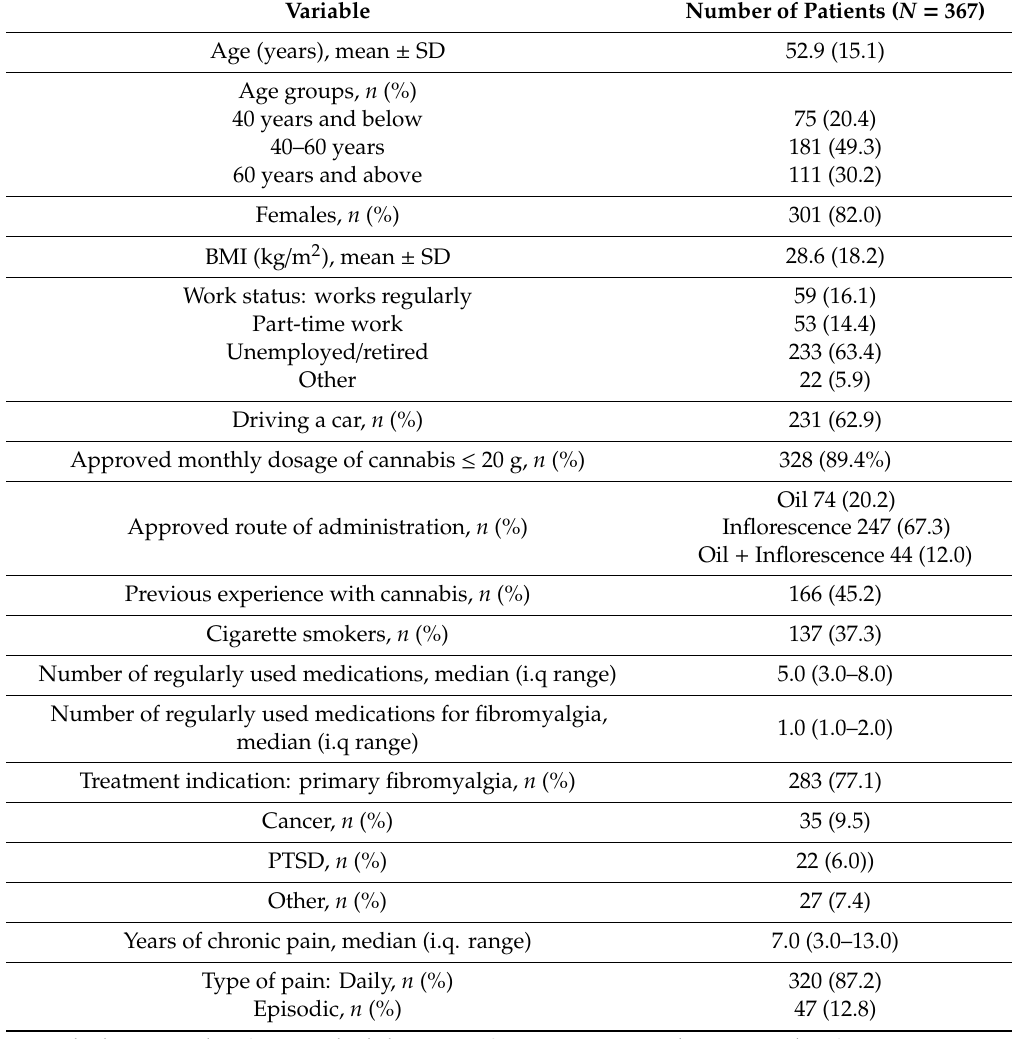
Table 1. Baseline characteristics of the patient